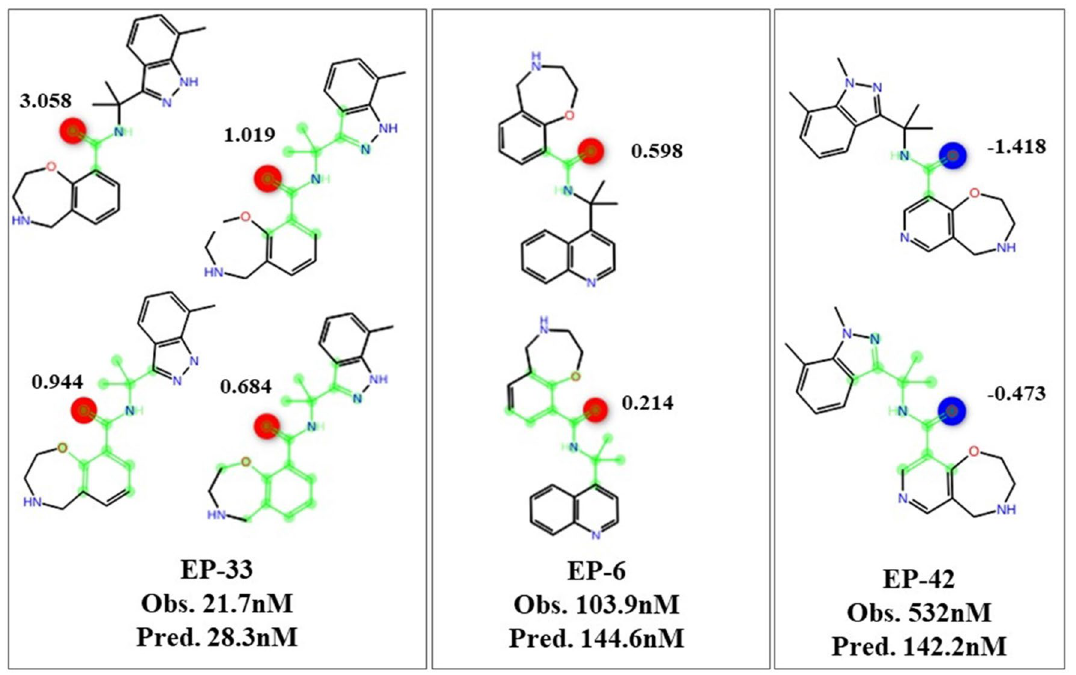
Fig. 9 Three EP structures with different affinities. Green are frag- ments associated to the carbonyl oxygen atom. Blue denotes atoms that decrease affinity, red indicates atoms that increase affin- ity. Replacement of indazole (EP-33) by a quinoline (EP-6) results in two fragments that are common, one of which has a markedly